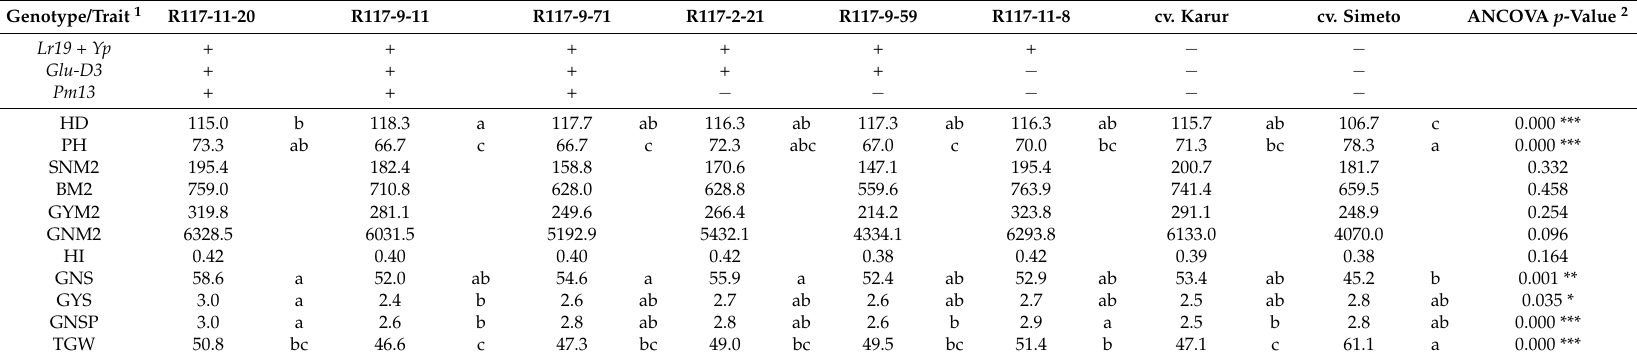
Table 1. Mean values of yield-related traits 1 recorded on recombinant and control durum wheat genotypes in 2015 growing season and p -values from the ANCOVA analysis. Letters in each row correspond to the ranking of Tukey HSD test at p <